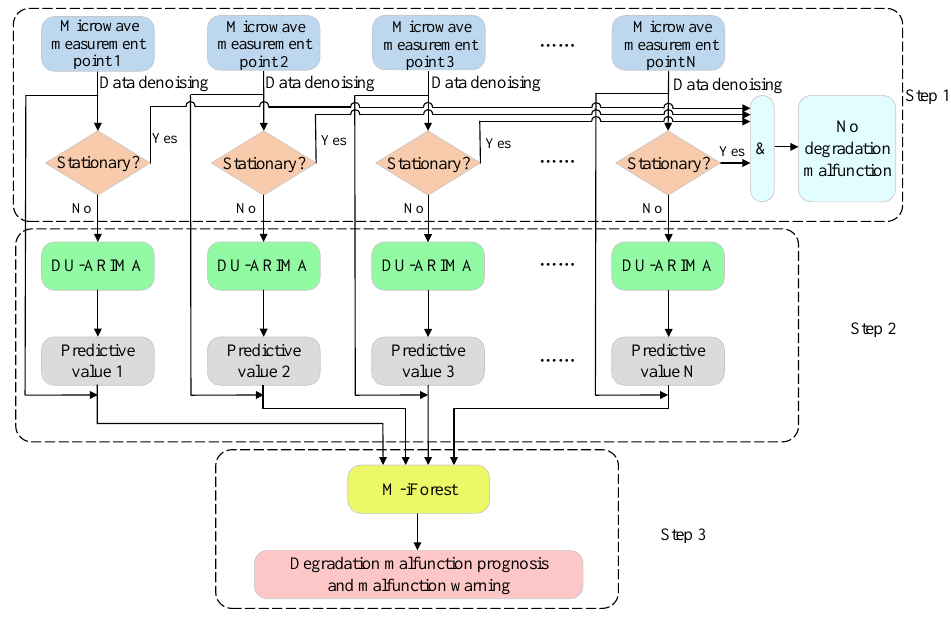
Figure 1. The flow chart of the degradation malfunction prognosis